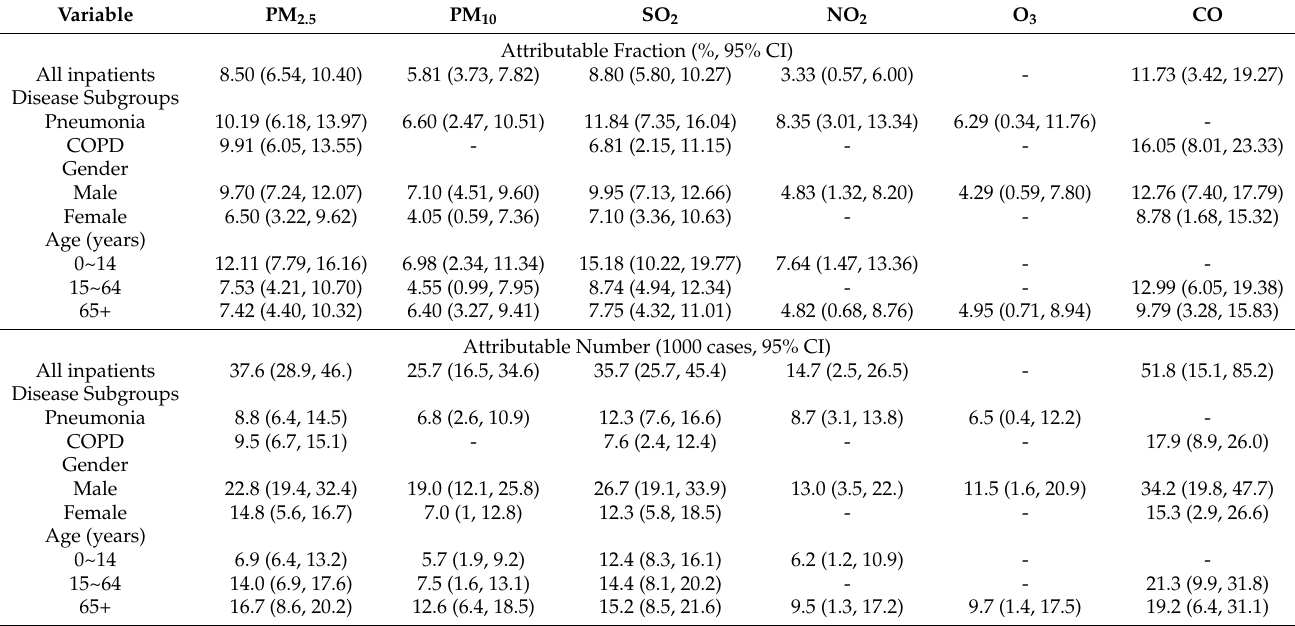
Our research shows the attributable fractions, which represent the proportion of excessive hospital admissions due to air pollutant (PM 2.5, PM 10 , SO 2 , NO 2 , and CO) exposure to the total number of hospital admissions, are 8.50%, 5.81%, 8.80%, 3.33%, and 11.73%, respectively. Based on the attributable fraction, further estimation shows that the number of hospital admissions for respiratory diseases attributable to PM 2.5, PM 10 , SO 2 , NO 2 , and CO exposure is 37,600, 25,700, 35,700, 14,700, and 51,800, respectively. The attributable risk differed by disease subgroups, gender groups, and age groups; for example, more males than females are hospitalized for respiratory disease due to PM 2.5 , 22,800 for the former and 14,800 for the latter with attributable fractions of 9.70% and 6.50%, respectively. The number of hospital admissions for respiratory diseases due to PM 10 rose with age, with 5700 cases (ages 0–14), 7500 cases (15–64), and 12,600 cases (65+) with attributable fractions of 6.98%, 4.55%, and 6.40%, respectively. SO 2 caused more hospital admissions for pneumonia (12,300 cases) than COPD (7600 cases), with attributable fractions of 11.84% and 6.81%, respectively. See Table 10 for details. Table 10. Attributable analysis results of hospital admissions for respiratory diseases due to air pollutants.